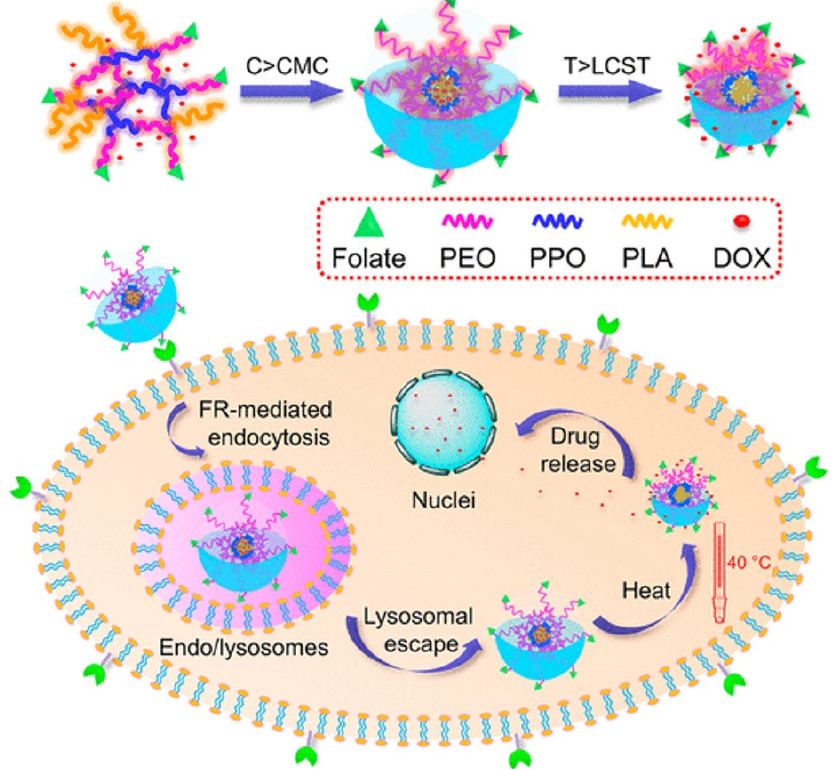
Figure 6. Schematic Representation of Thermosensitive Nanocarrier Working as a Targeted Drug Delivery System with Controlled Drug Release. Reprinted with permission from ref. [178]. Copyright © 2014 American Chemical Society.